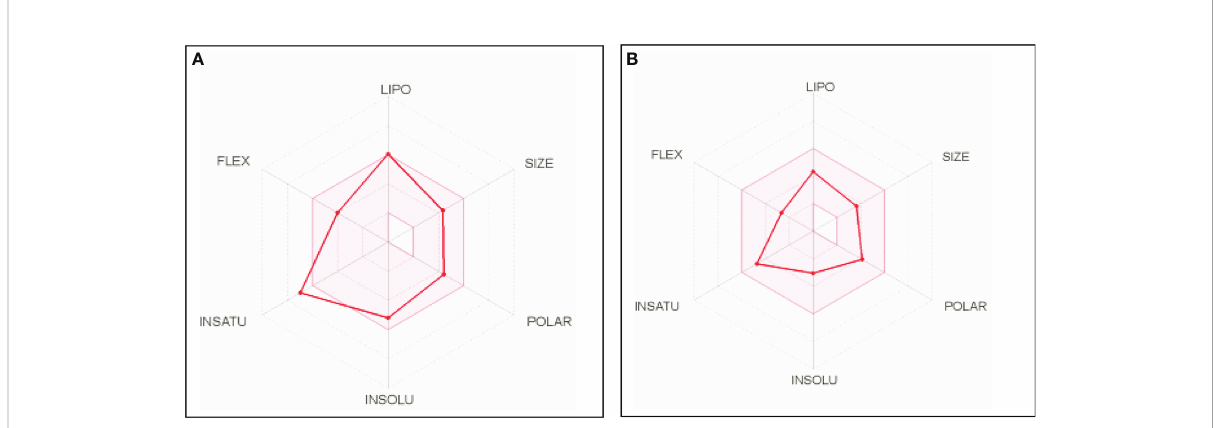
FIGURE 4 Bioavailability radar plots of (A) xanthohumol and (B) anastrozole. LIPO=lipophilicity (between − 0.7 and +5.0), SIZE=molecular weight (between 150 and 500g/mol), POLAR=polarity (between 20 and 130 Å 2 ), INSOLU=solubility (not higher than 6), INSATU=saturation (fraction of carbons in the sp3 hybridization not less than 0.25), FLEX= fl exibility (no more than 9 rotatable bonds).